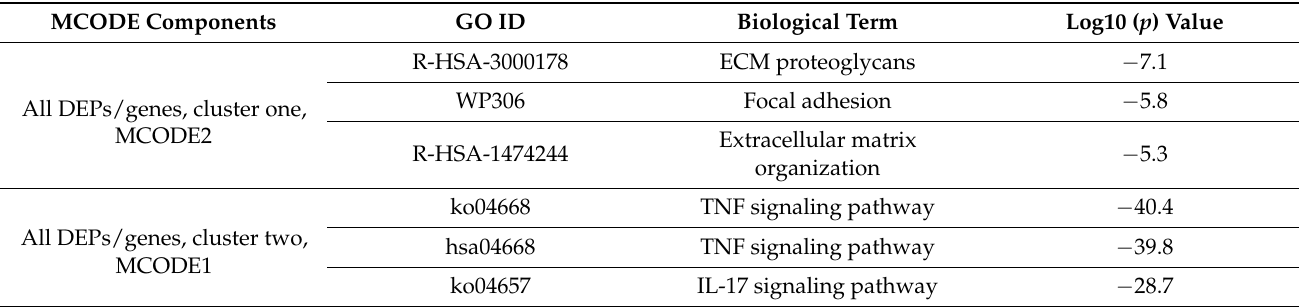
Table 3. Results of Molecular Complex Detection (MCODE) analysis performed on differentially expressed proteins (DEPs) and genes of death due to ischemic stroke. MCODE Components GO ID Biological Term Log10 ( p ) Value